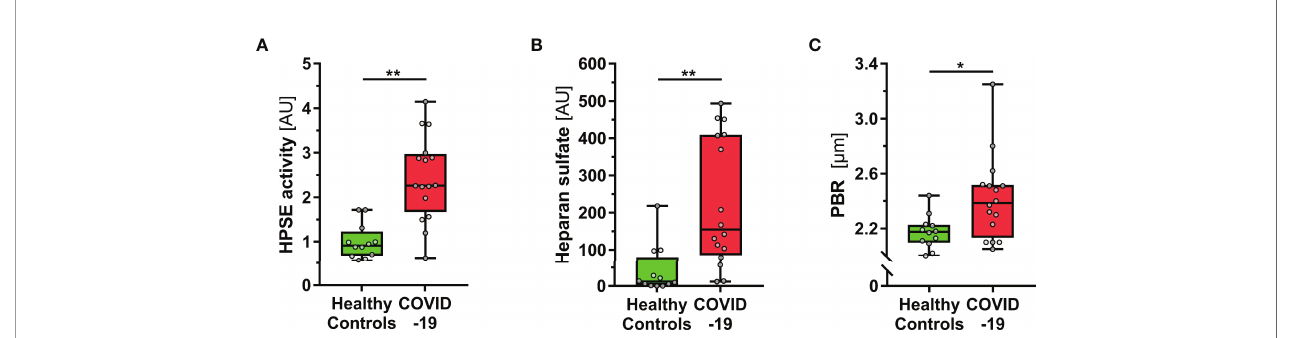
( Figure 1C and Table 1 ). All markers of eGC damage correlated with disease severity, as measured by SOFA score (HPSE: R